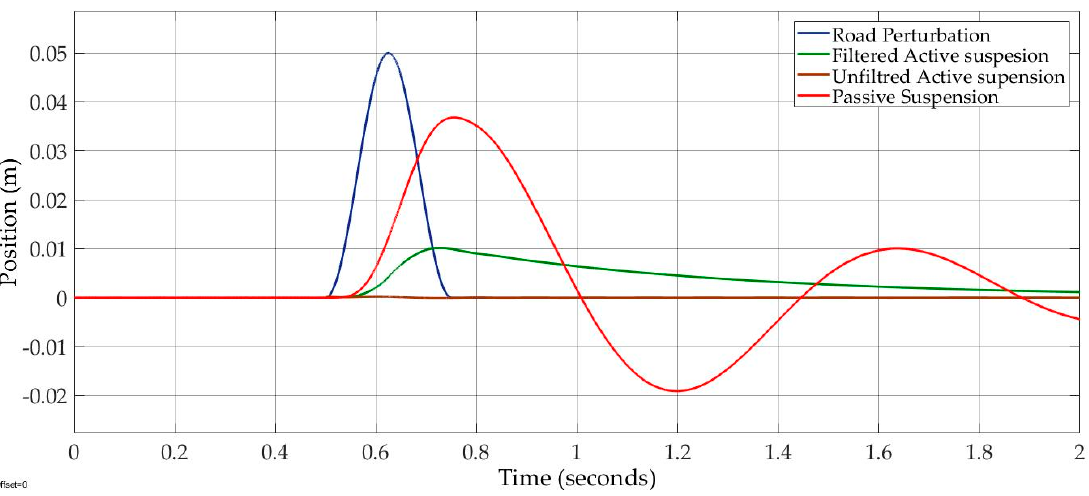
Figure 8. Sprung mass position of Case 1.